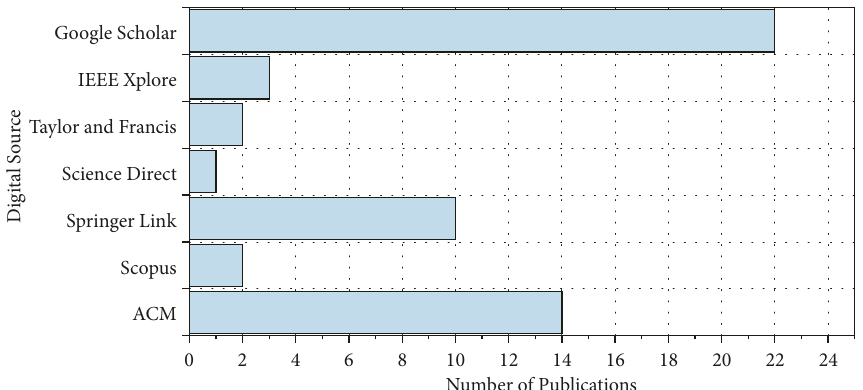
Figure 4: Distribution of primary studies across the seven digital sources utilised in this systematic review. The eighth digital source (Web of Science) is not shown due to overlapped content with earlier sources.